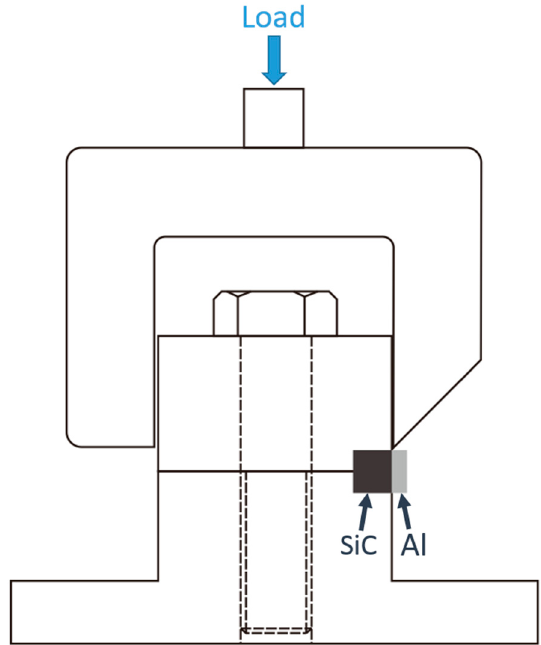
Figure 2. Schematic graph of the shear test jig.